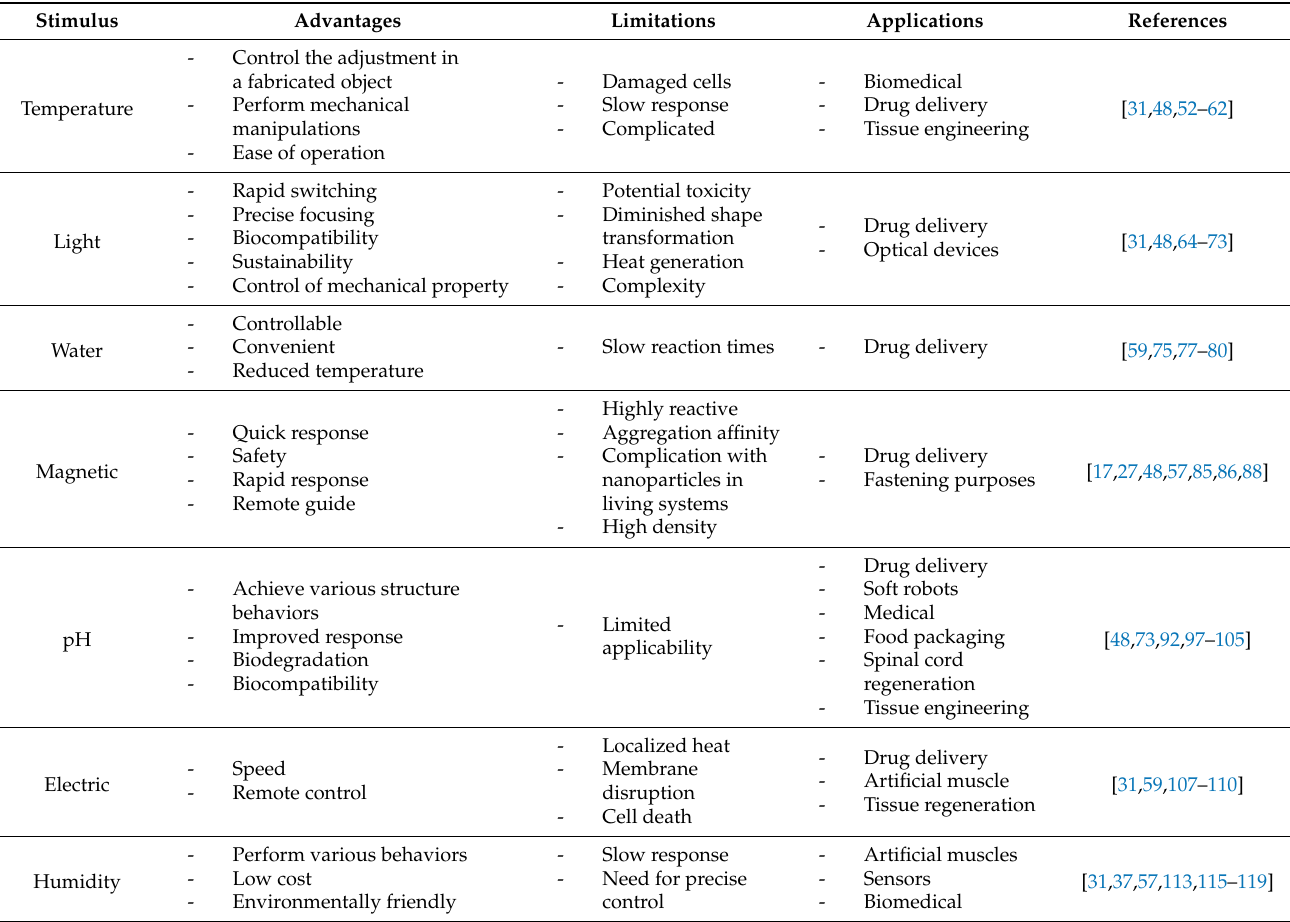
Table 3. Summary of Stimulus Factors Used in 4D Printing